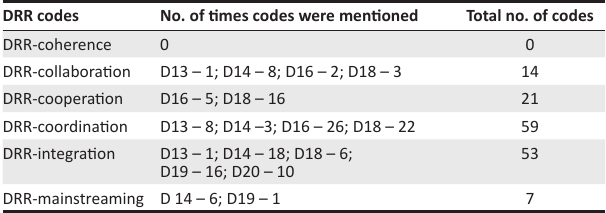
TABLE 7: Content in disaster risk reduction policies and legislation promoting coherence. TABLE 6: